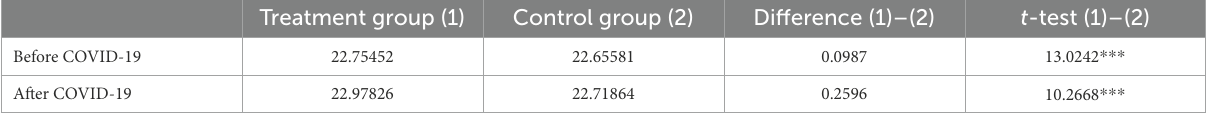
TABLE 4 Online learning intervention and students’ foreign language learning performance: Univariate t -test